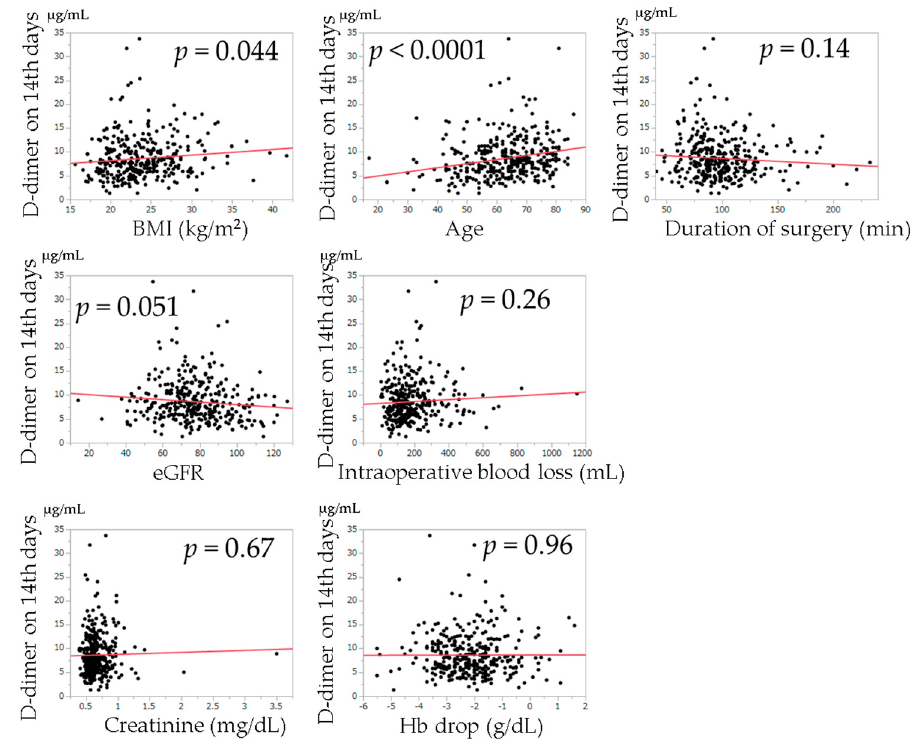
Figure 2. Univariate regression analysis of the relationships between each variable and D-dimer levels on the 7th postoperative day. The solid lines indicate regression lines. BMI: body mass index, eGFR: estimated glomerular filtration rate.